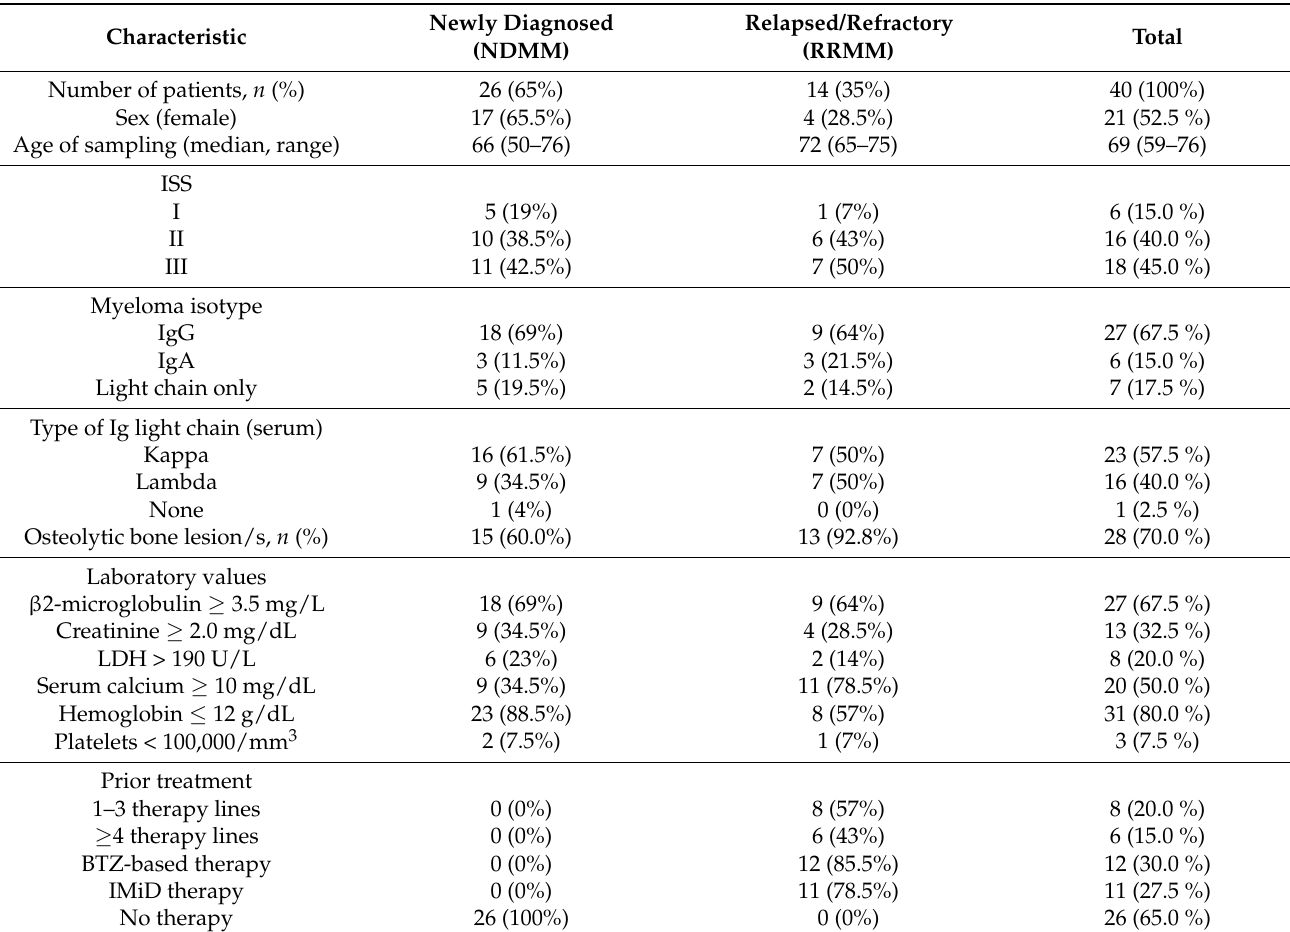
Table 6. Patient demographics and